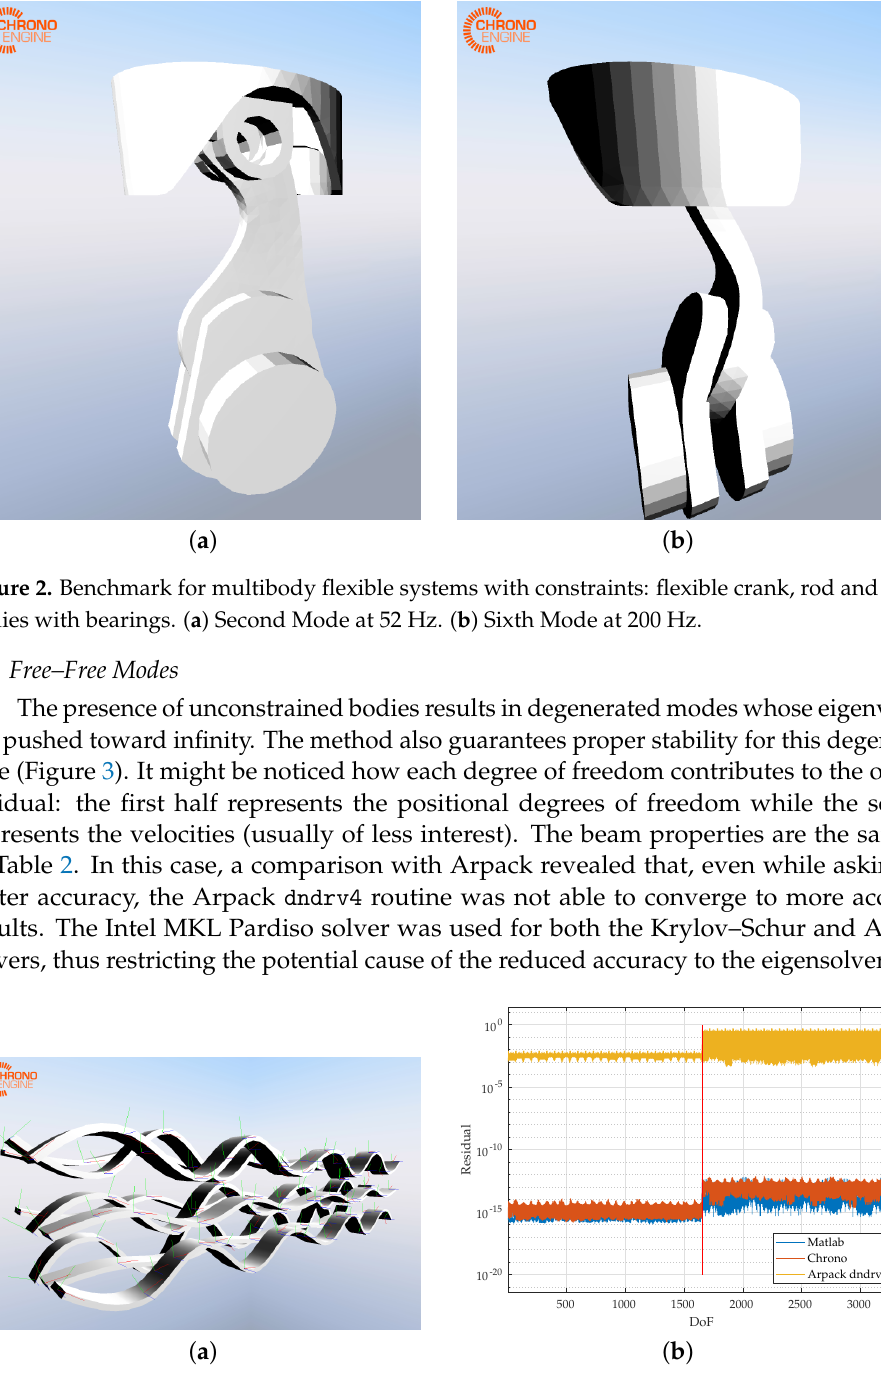
Figure 3. Benchmark with multiple rigid body modes. ( a ) Free–free models. ( b ) Free–free eigensolver